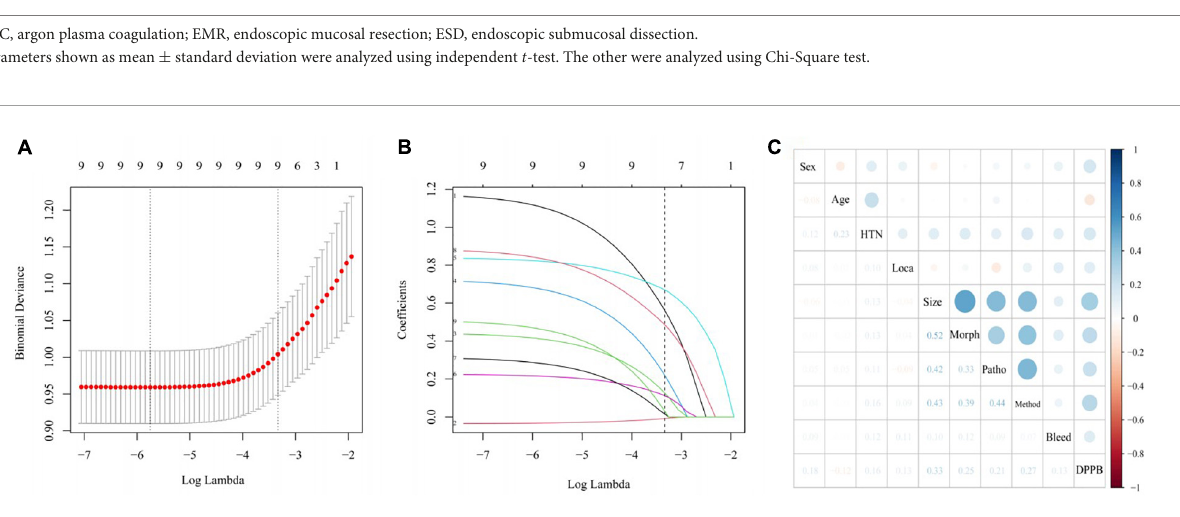
FIGURE2 Variable selection using LASSO regression model. (A) Tuning parameter ( λ ) selection in the LASSO model used 10-fold cross-validation via minimum criteria. The lower horizontal coordinate shows the logarithmic value of λ , while the upper horizontal coordinate represents the number of variables with non-zero regression coefficient entering the model. (B) LASSO coefficient profiles of the 9 potential predictors. (C) Correlation between all variables in the LASSO model visualized by the diameters of the